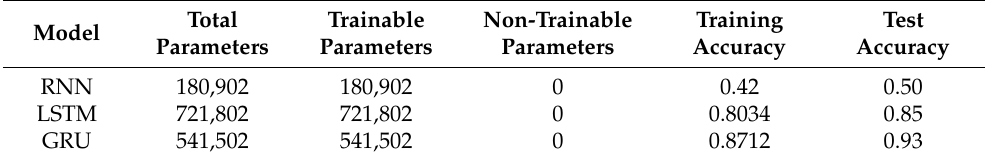
Table 5. Comparison of the data models during training.